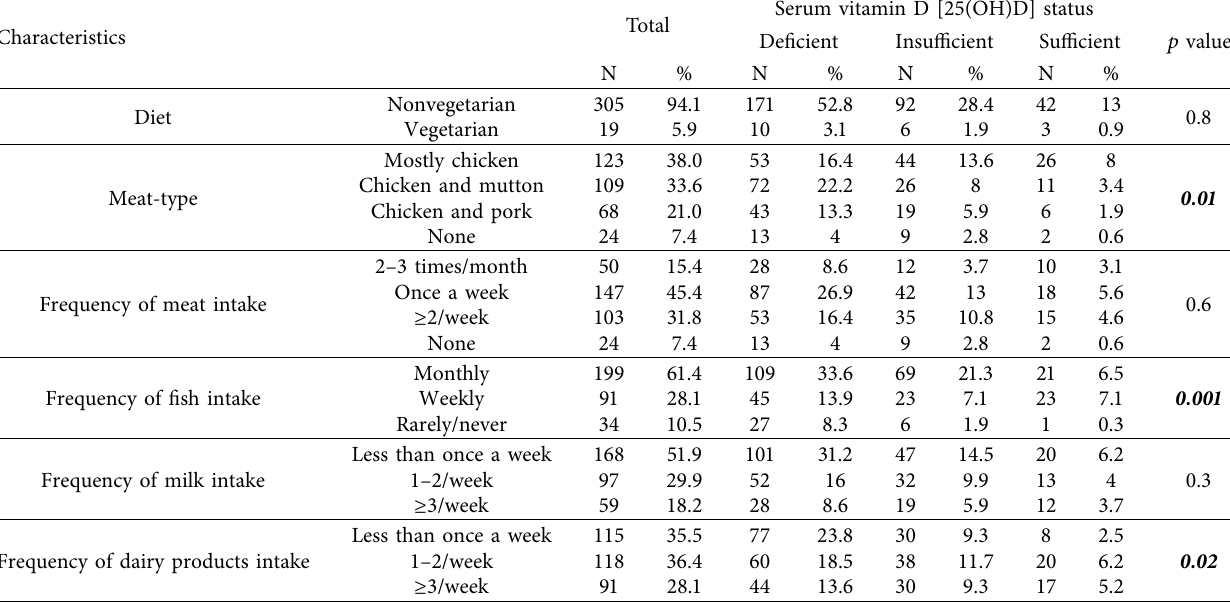
Table 2: Dietary pattern and vitamin D status.